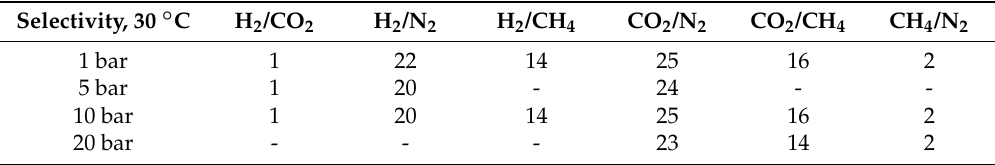
Table 4. Selectivity of PIM-EA(H 2 )-TB for CH 4 , N 2 , H 2 , CO 2 at 30 ◦ C for different pressures.